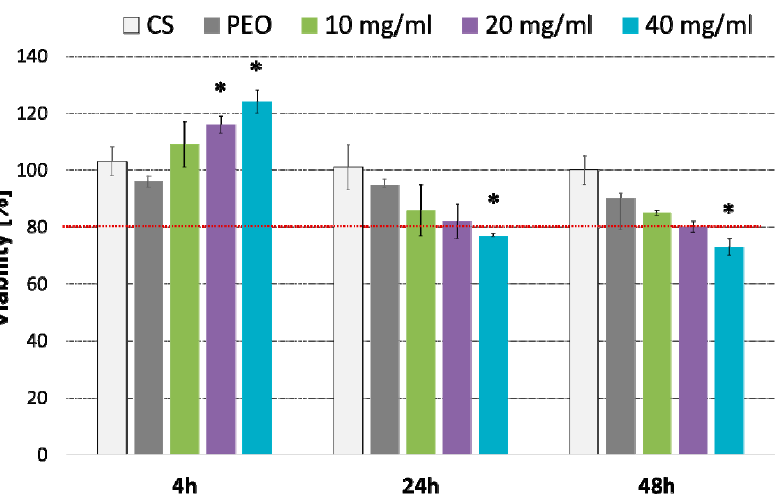
Figure 7. Column charts displaying viability of fibroblasts cells (as compared to untreated cells) incubated with different concentrations (expressed in mg/mL) of CS/PEO 10% nanofibers for 4, 24 or 48 h measured by MTT assay (mean ± SD; n = 3); cells treated with pure CS and pure PEO at concentrations corresponding to those in extract sample CS/PEO 10% at 40 mg/mL were used as controls. * represents significant differences with p ≤ 0.05 in comparison to untreated cells.